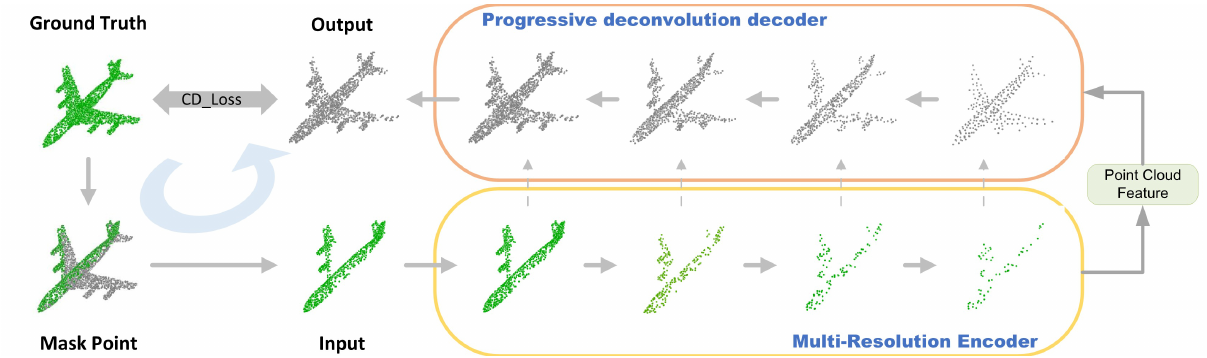
Figure 1. PCA-Net generates the ground-truth point cloud as a missing point cloud by the multi-view missing point cloud generation method (the viewpoints are selected as [0, 0, 1], the green part is the viewable point, and the gray part is the hidden point). Then, the green viewable points are input to multi-resolution encoder to generate point cloud feature, and the complete point cloud output is generated by progressive deconvolution decoder (the resolution of encoder is N, N/2, N/4, and N/8, and the resolution of decoder, N/8, N/4, N/2, and N). CD_Loss (Chamfer Distance in Section 3.3) to evaluate the difference between predicted and true